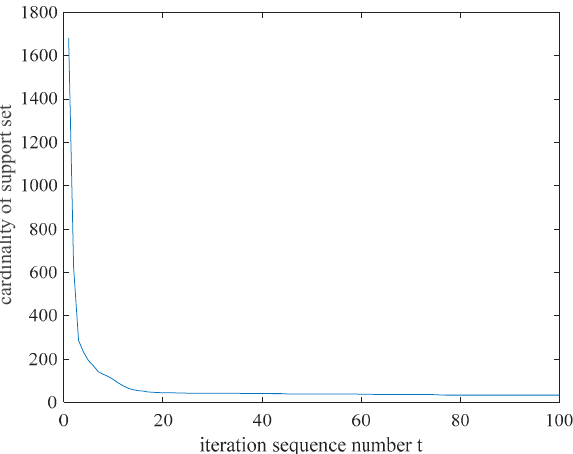
Figure 2. Cardinality of support set against iteration sequence number t.